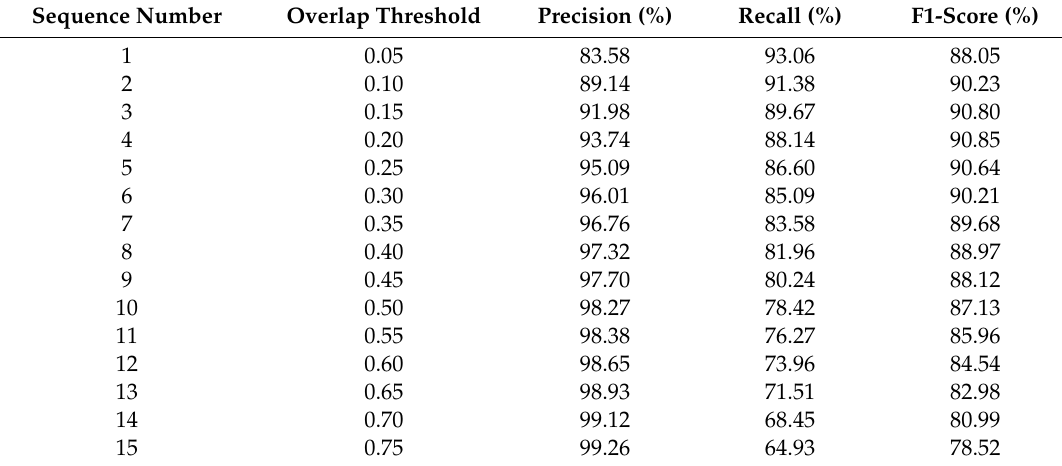
Table 5. The multiple test results under di ff erent overlap